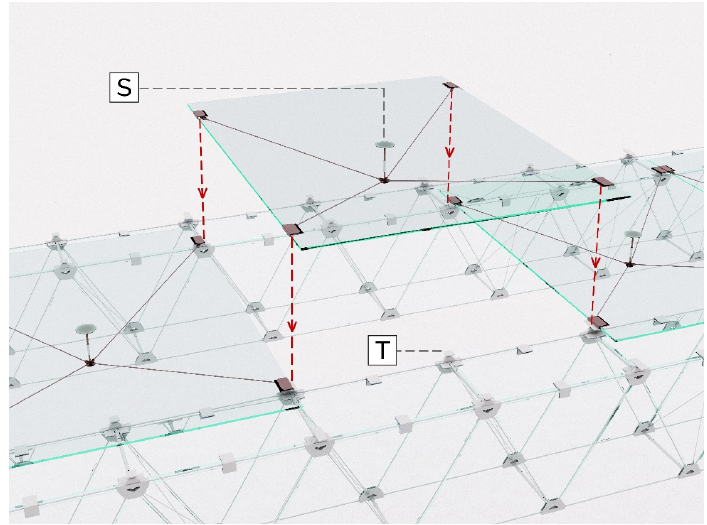
Figure 8. Hybrid longitudinal roof bracing system: S—steel tubular strut; T—intermediate midspan support of the panel out ‐ of ‐ plane load.